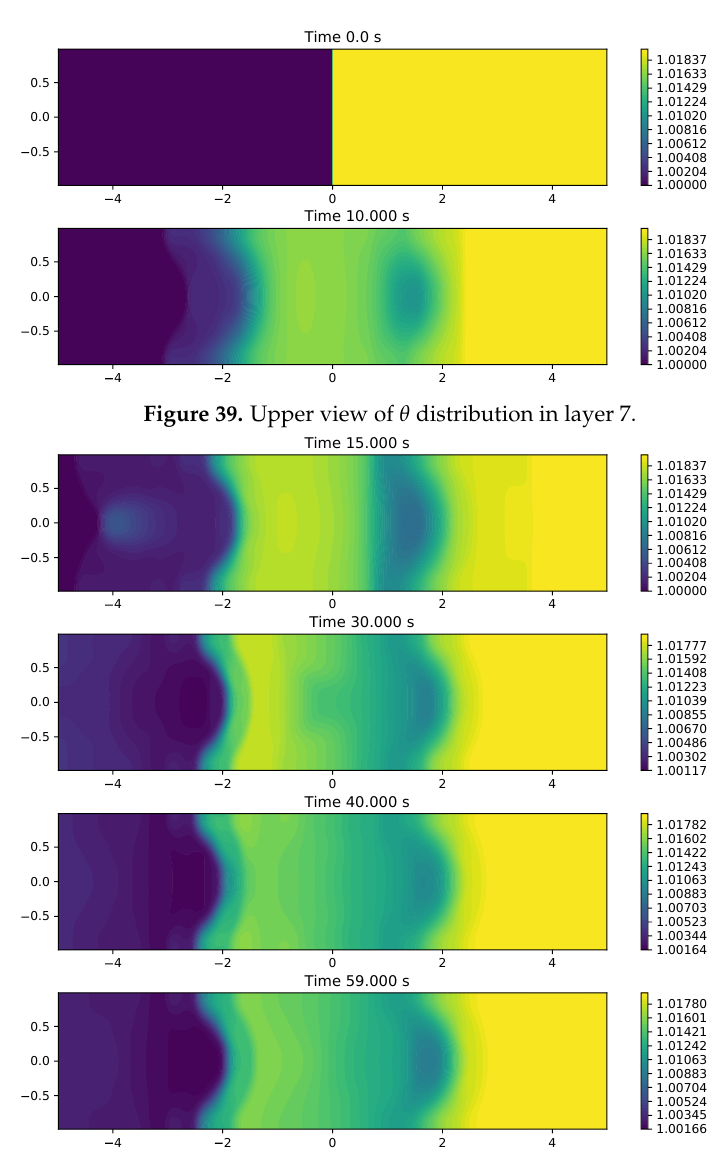
Figure 40. Upper view of θ distribution in layer